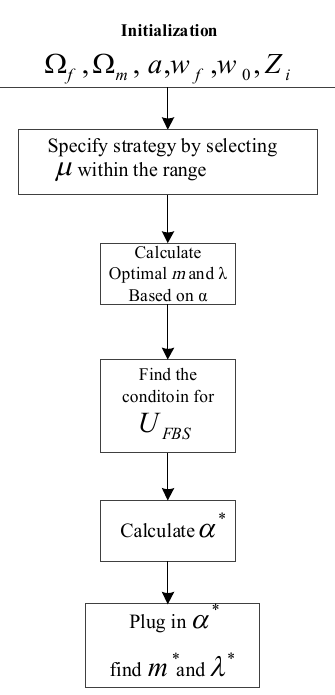
Figure 1. Solution procedure.